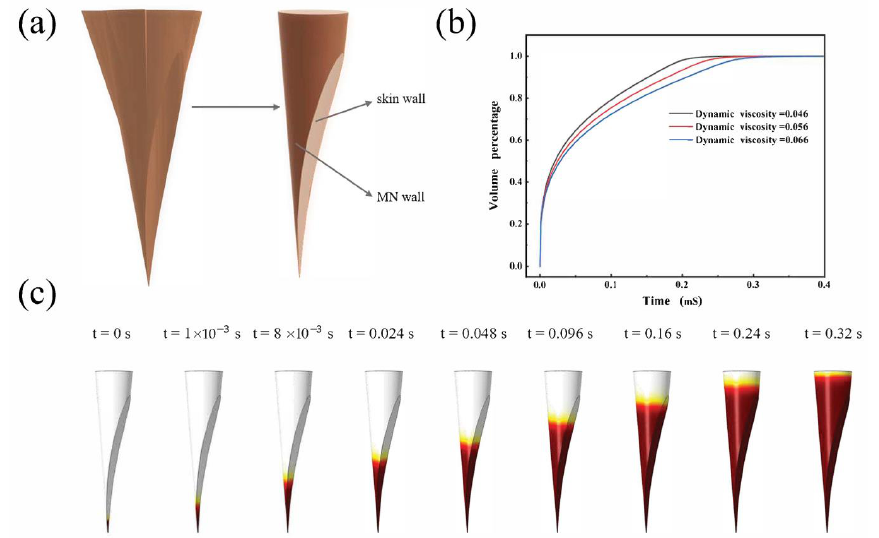
Figure 6. ( a ) Three-dimensional structure of hollow microneedles and formation of hollow channels by the MN wall and skin tissue. ( b ) Rising velocity of droplets with different kinetic viscosities; 0.056 is the standard value for ISF. ( c ) Extraction of ISF time-lapse simulation results, initially moving faster and then slower through the closed channel.